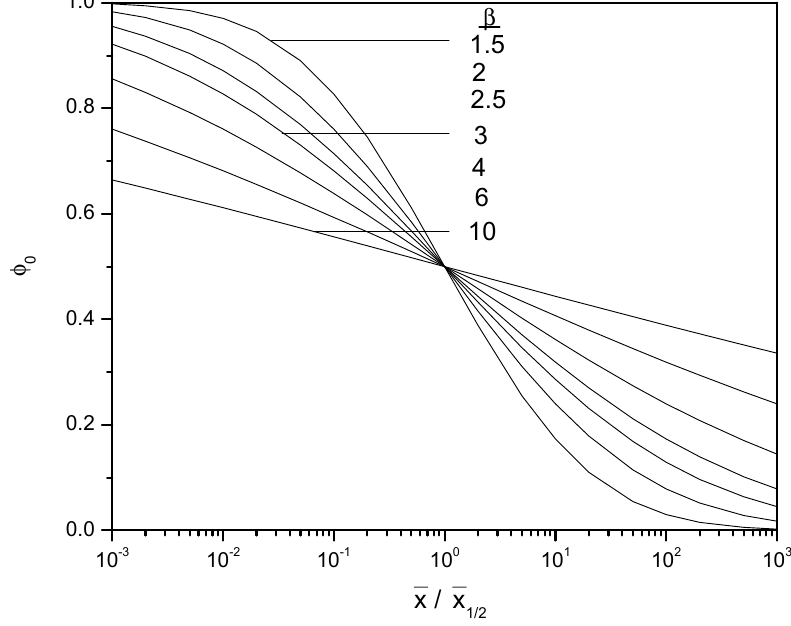
( (cid:1876)̅ ), Equation (5), for the Coefficient of Variation of the Figure A1. The fitting function Φ 0 mean (cid:1829) (cid:3023)(cid:3041) as a function of (cid:1876)̅/(cid:1876)̅ for seven values of β . The mean is represented by (cid:1876)̅ (cid:2869)/(cid:2870)